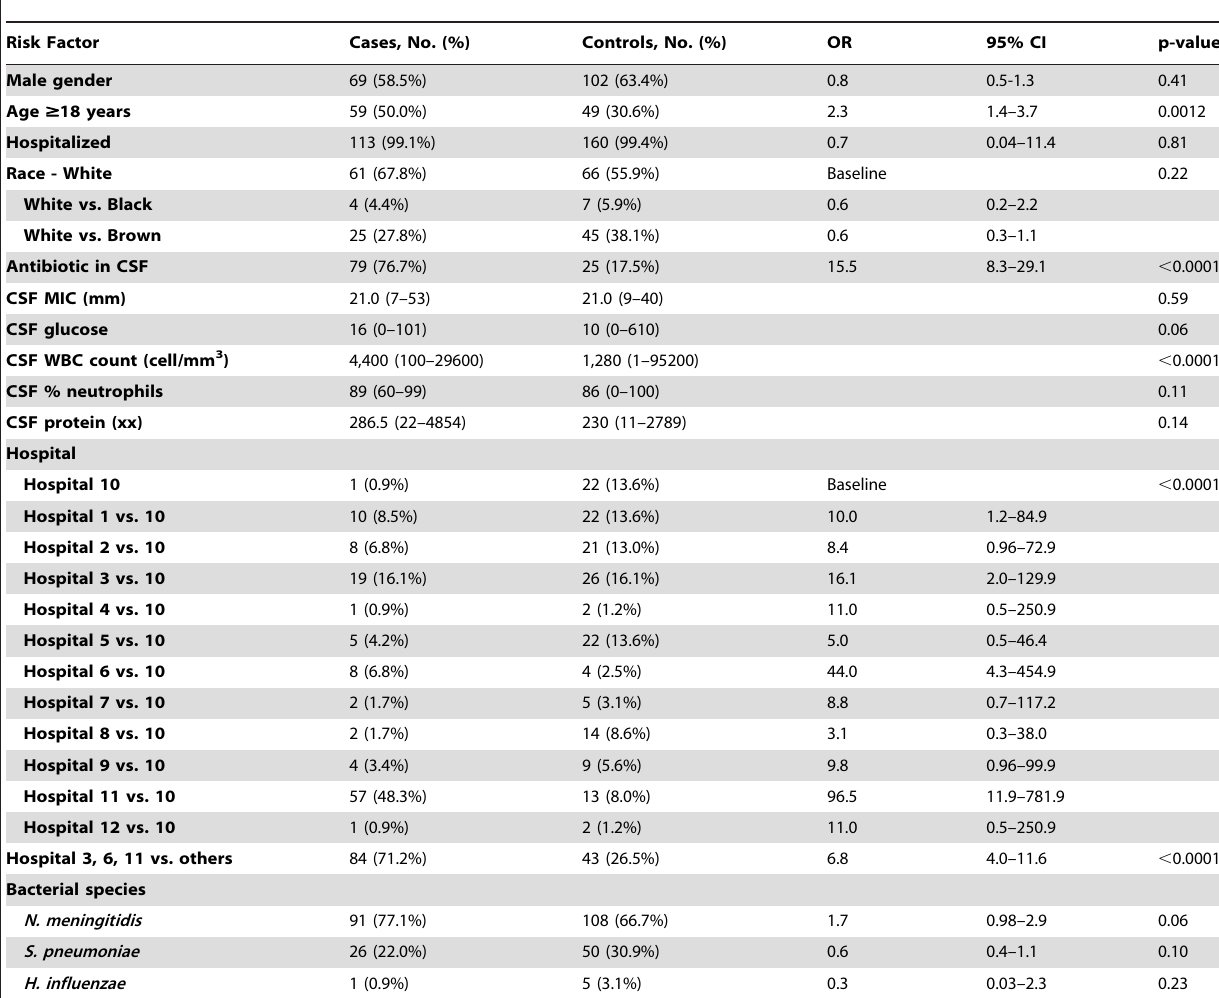
Table 3. Univariate analysis of risk factors for being a RT-PCR positive, culture-negative case-patient, using culture positive patients as